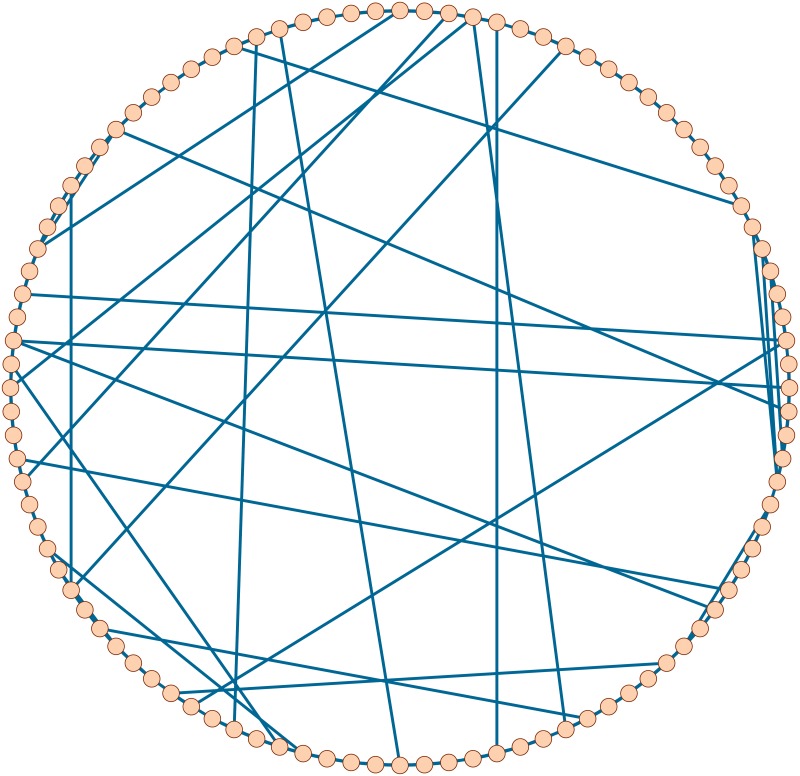
A synthetic small-world network GSW.